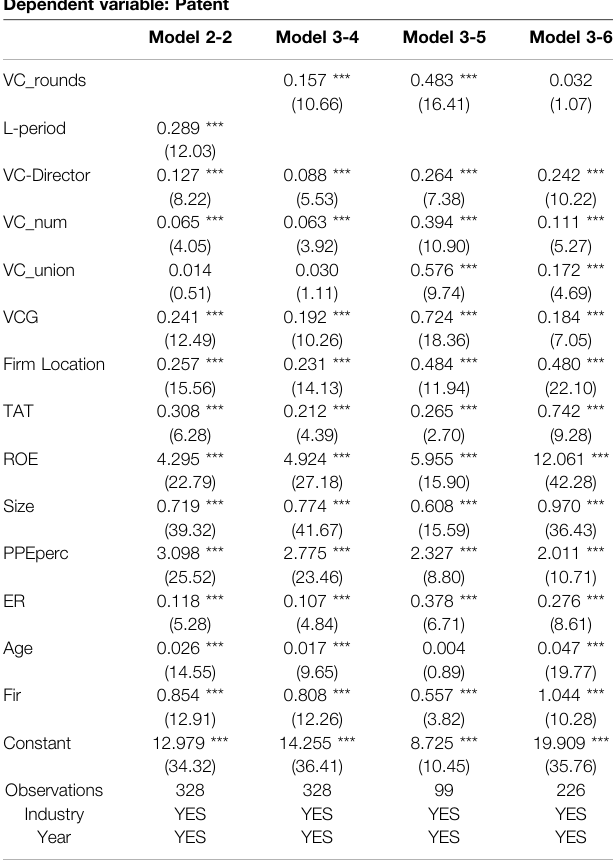
TABLE 6 | Regression after